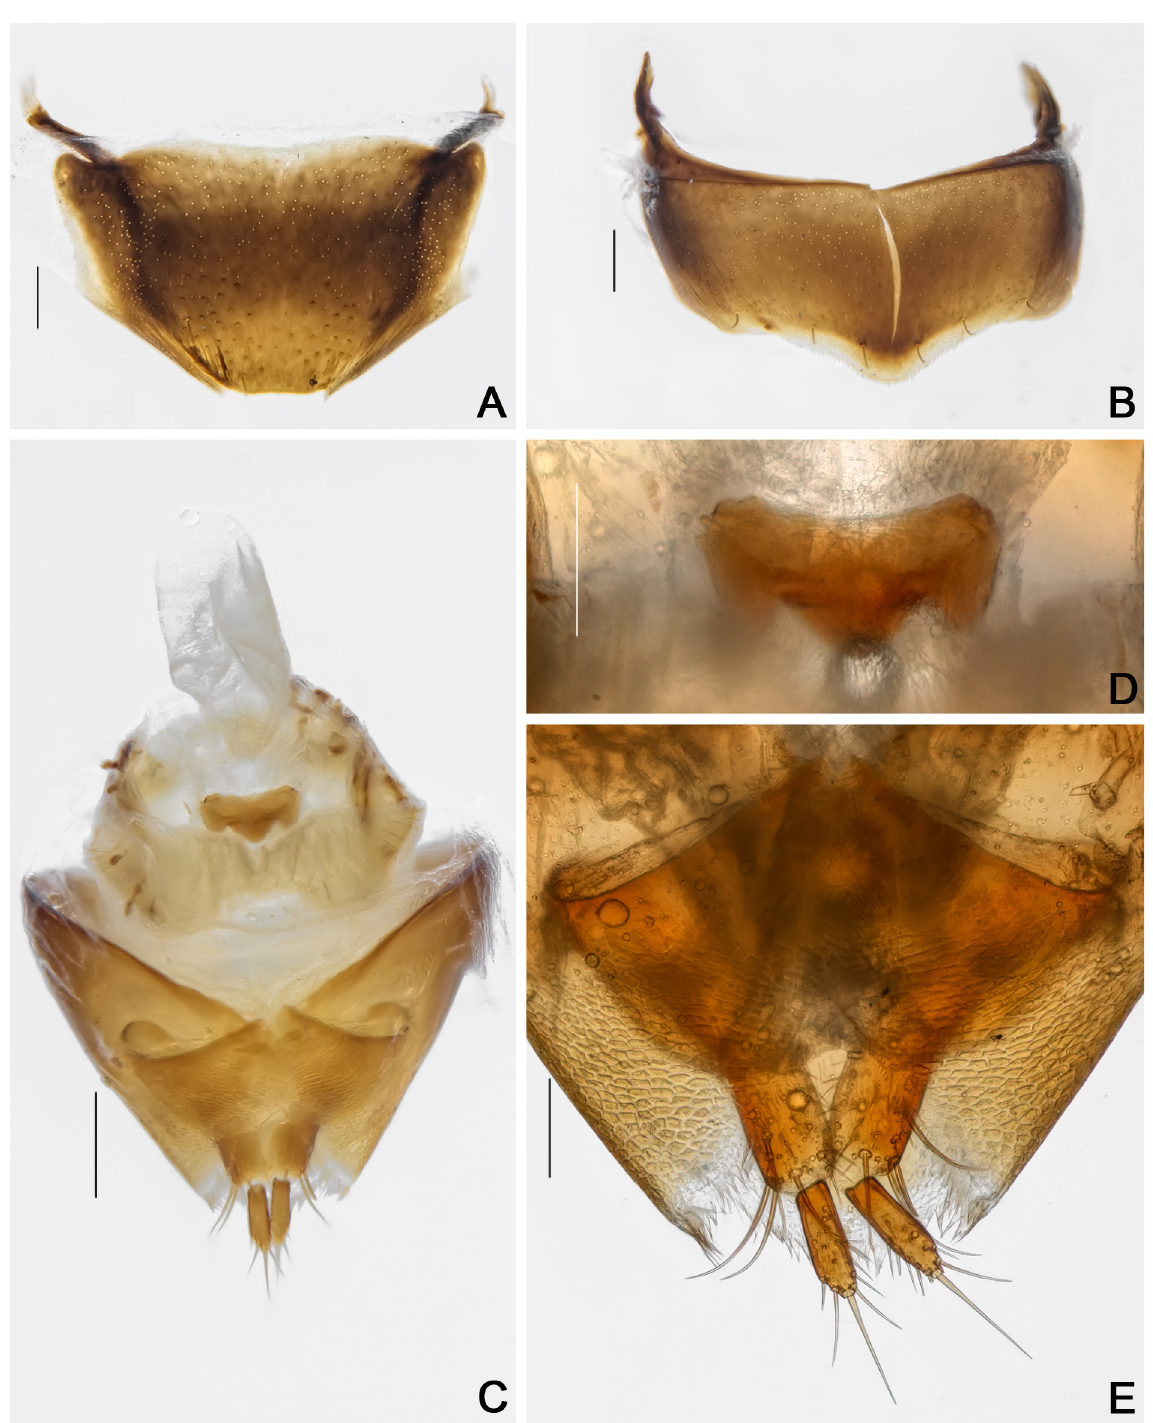
Fig. 45. Cyparium pici sp. nov., paratype, ♀ (CELC). A . Tergite VIII. B . Sternite VIII. C . Terminalia. D . Sclerite of vaginal plate. E . Ovipositor. Specimen collected at Cotriguaçu (MT, Brazil). Scale bars = 0.1